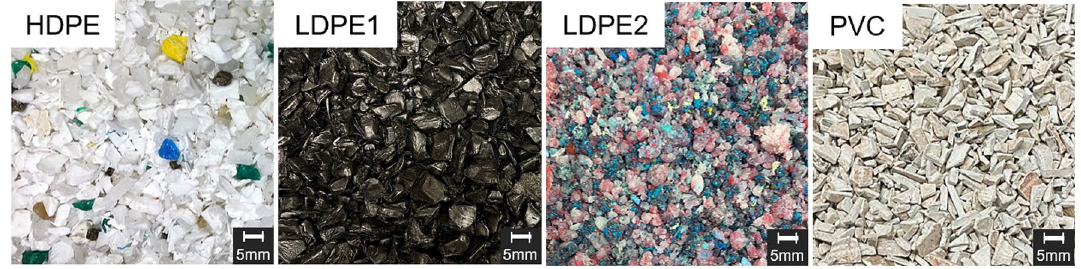
Figure 1. Clean waste plastic gifted by Northwest